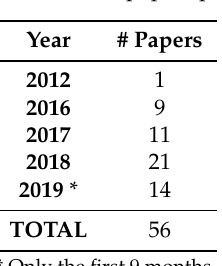
Table 1. Number of papers per year.